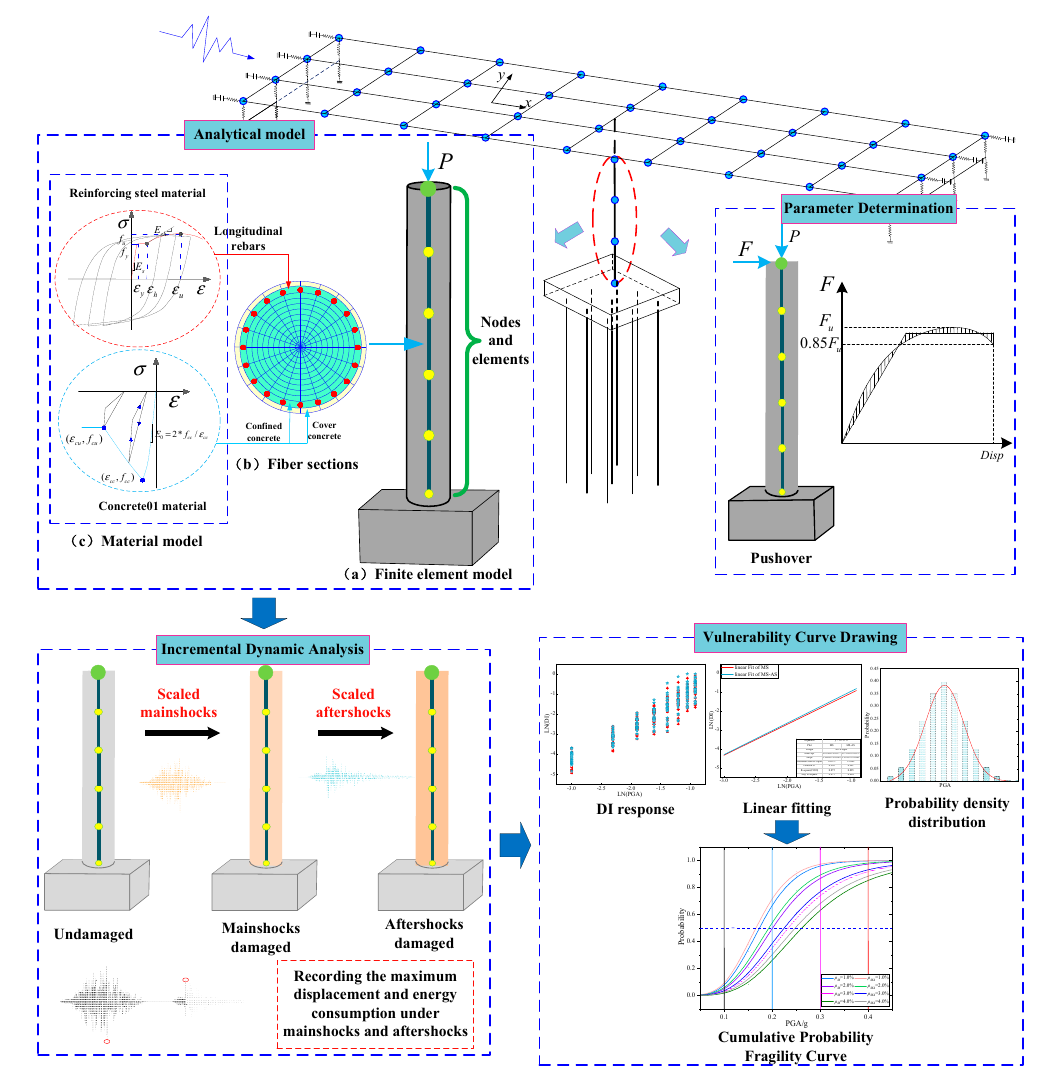
Figure 2. Bridge column fiber model. Table 2. Basic parameters of reinforcement.